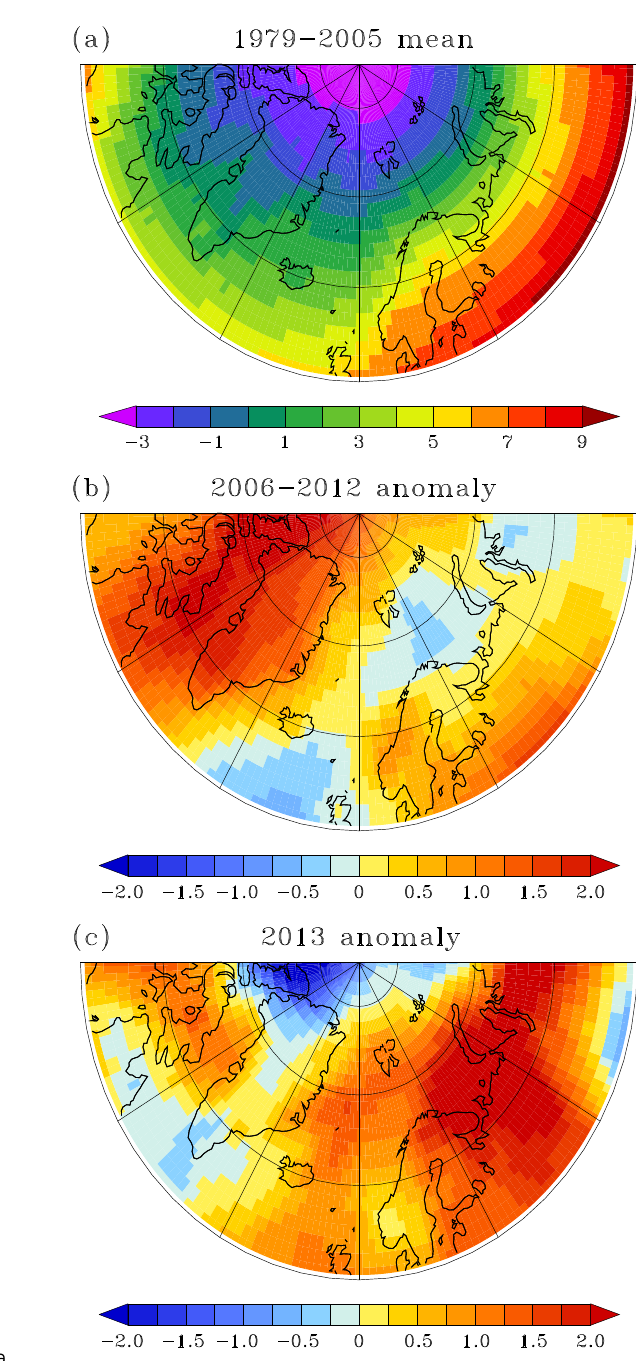
Figure 5. (a) 1979–2005 T850 JJA mean ( ◦ C) from ERA-Interim. (b) 2006–2012 mean T850 JJA anomaly ( ◦ C) with respect to the 1979–2005 mean. (c) Same as (b) but for